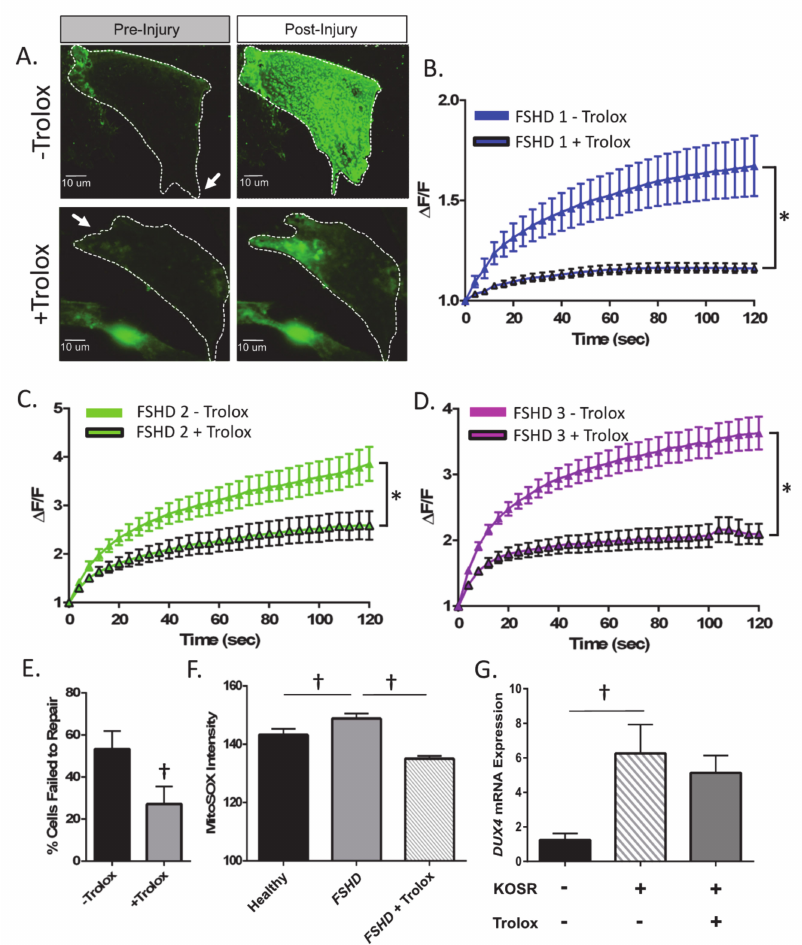
Figure 3. Treatment of FSHD-immortalized myoblasts with Trolox improves membrane repair. ( A ) Images of FM1-43 dye entry in injured myoblasts at baseline (pre-injury) and at 120 s post-injury in control FSHD myoblasts (FSHD1 n = 18 cells, FSHD2, n = 16 cells, FSHD3 n = 30 cells), and FSHD myoblasts treated for 24-h with 500 µ M Trolox (FSHD1 n = 23 cells, FSHD2, n = 16 cells, FSHD3 n = 42 cells). Arrow indicates location of laser injury. ( B – D ) Change in intracellular FM1-43 dye fluorescent intensity ( ∆ F / F) over time for control FSHD myoblasts and FSHD myoblasts treated with Trolox. Greater dye entry indicates worse repair. ( E ) Percentage of cells that failed to repair with and without Trolox treatment. Values are mean ± SEM. ( F ) FSHD myoblasts (FSHD1) demonstrate elevated mitochondrial ROS, which was mitigated following 24 h of Trolox treatment ( n = 32–37 cells / condition, p < 0.05). ( G ) The culturing protocol (three days in LHCN –DEX, three days in 15% KOSR media) significantly increases DUX4 mRNA expression in FSHD muscle cells. However, 24-h treatment with 500 µ M Trolox treatment did not a ff ect DUX4 mRNA expression. Values are mean ± SEM. * indicates significant treatment ( + Trolox vs. –Trolox)*time interaction for FM1-43 intensity at p < 0.05. † denotes di ff erence between FSHD myoblasts treated with and without Trolox, paired t -test, p <